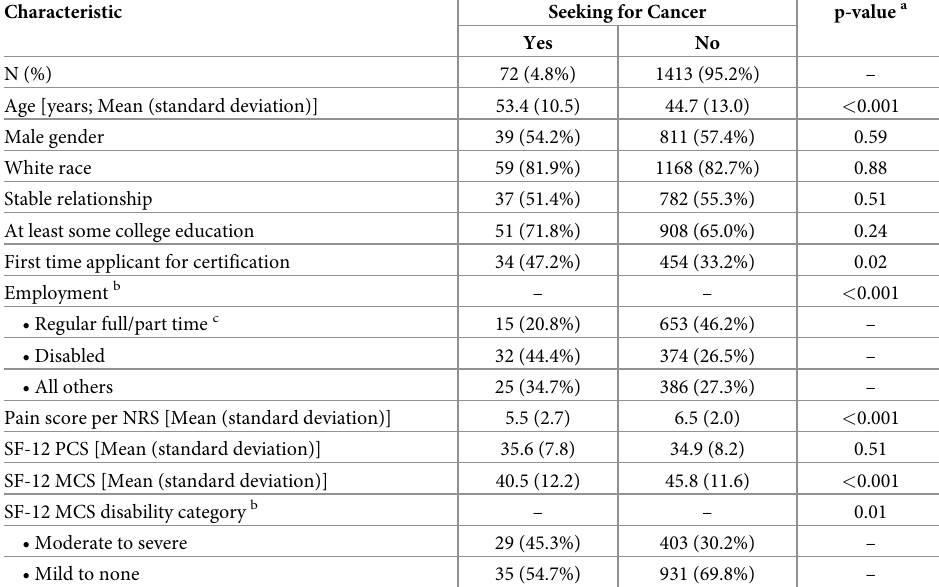
Table 1. Demographic and health characteristics of individuals seeking medical Cannabis certification for cancer versus not for cancer.